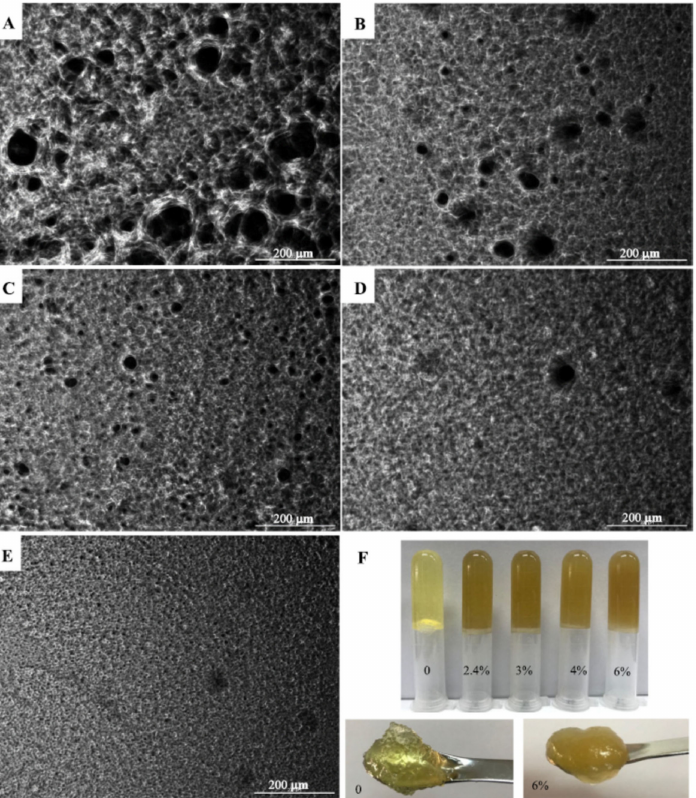
Figure 6. Microstructures (sorbitan monopalmitate content ( A ): 0, ( B ): 2.4%, ( C ): 3%, ( D ): 4%, ( E ): 6%) and macroscopic properties ( F ) of ethylcellulose (EC) oleogels. Sorbitan monopalmitate (SP) concentration corresponded to SP:EC ratios of 0, 1:5, 1:4, 1:3, 1:2. Reprinted from [89], with permission from